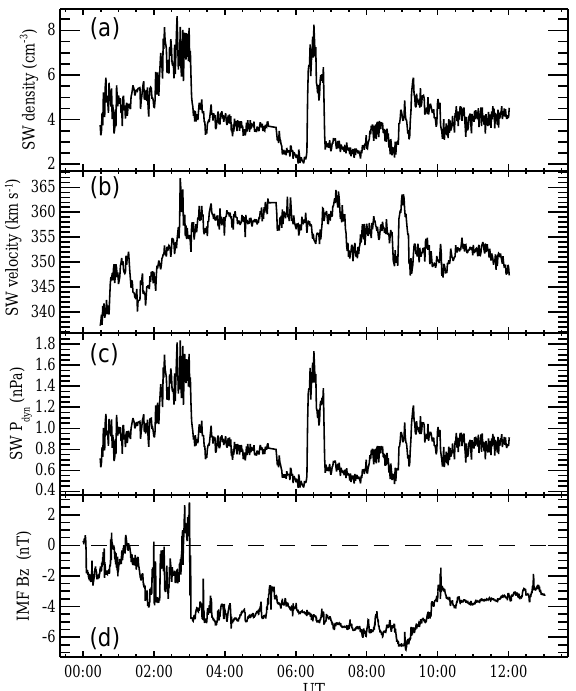
Figure 10. Solar wind properties measured by the ACE satellite on 26 January 2001 (same format as Fig. 2). The timescale has been shifted by 78min to approximately account for the propagation time between the spacecraft and the